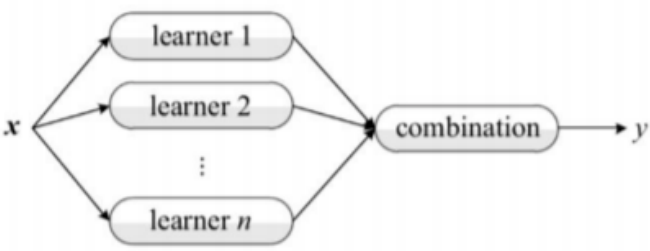
Figure 2. XGBoost Figure 2. XGBoost methodology.